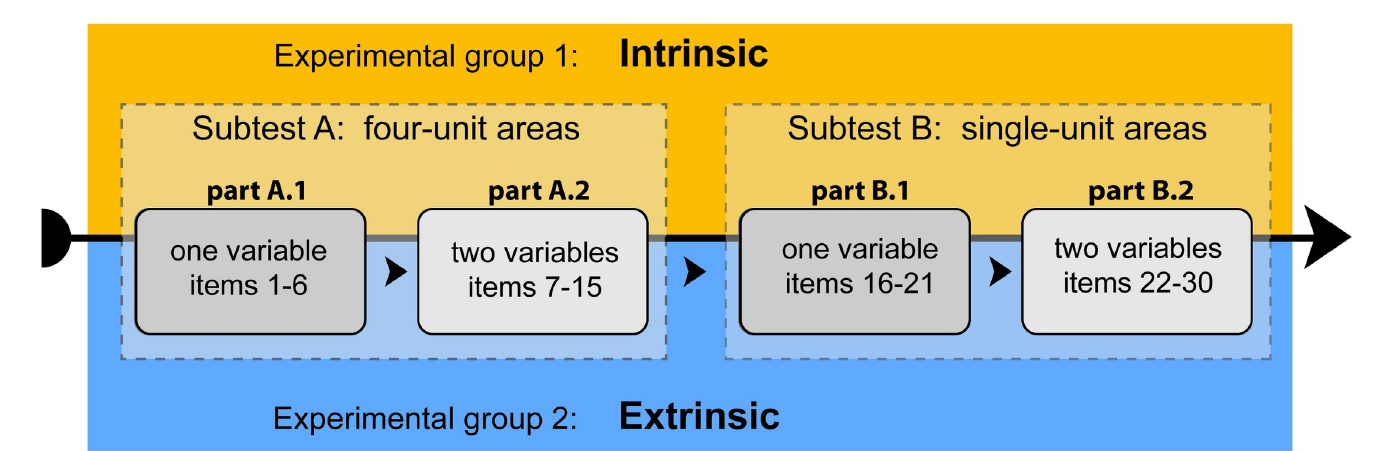
Fig 5. Between-subject experimental design (subtests A and B; parts A.1, A.2, B.1 and B.2). Both independent experimental groups, Intrinsic and Extrinsic, performed the test in exactly the same manner. The order of all items was constant for both groups, and all participants.